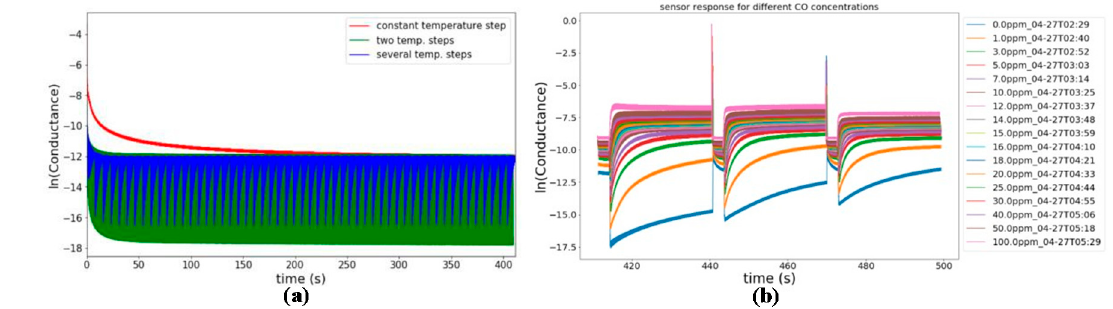
Figure 2. ( a ) Response curves (ln( G )) to different TMO modes—Exp1 (i)–(iii); ( b ) Response curves (ln( G )) to the three temperature jumps for different concentrations of